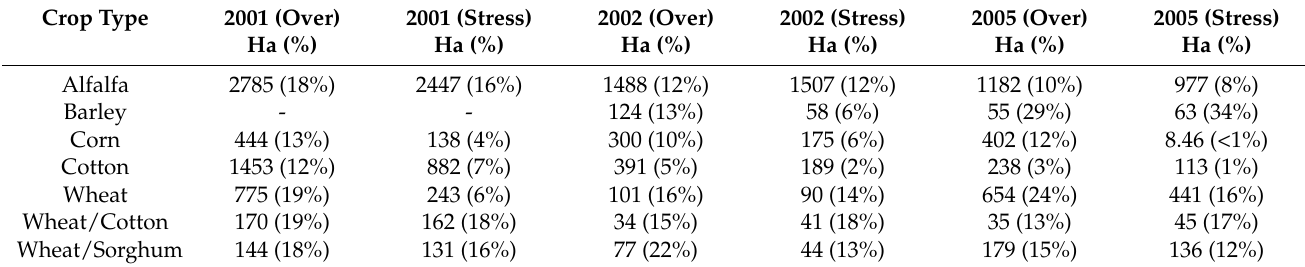
Table 12. Notably excessive water consumption and considerably low water consumption areas by crop